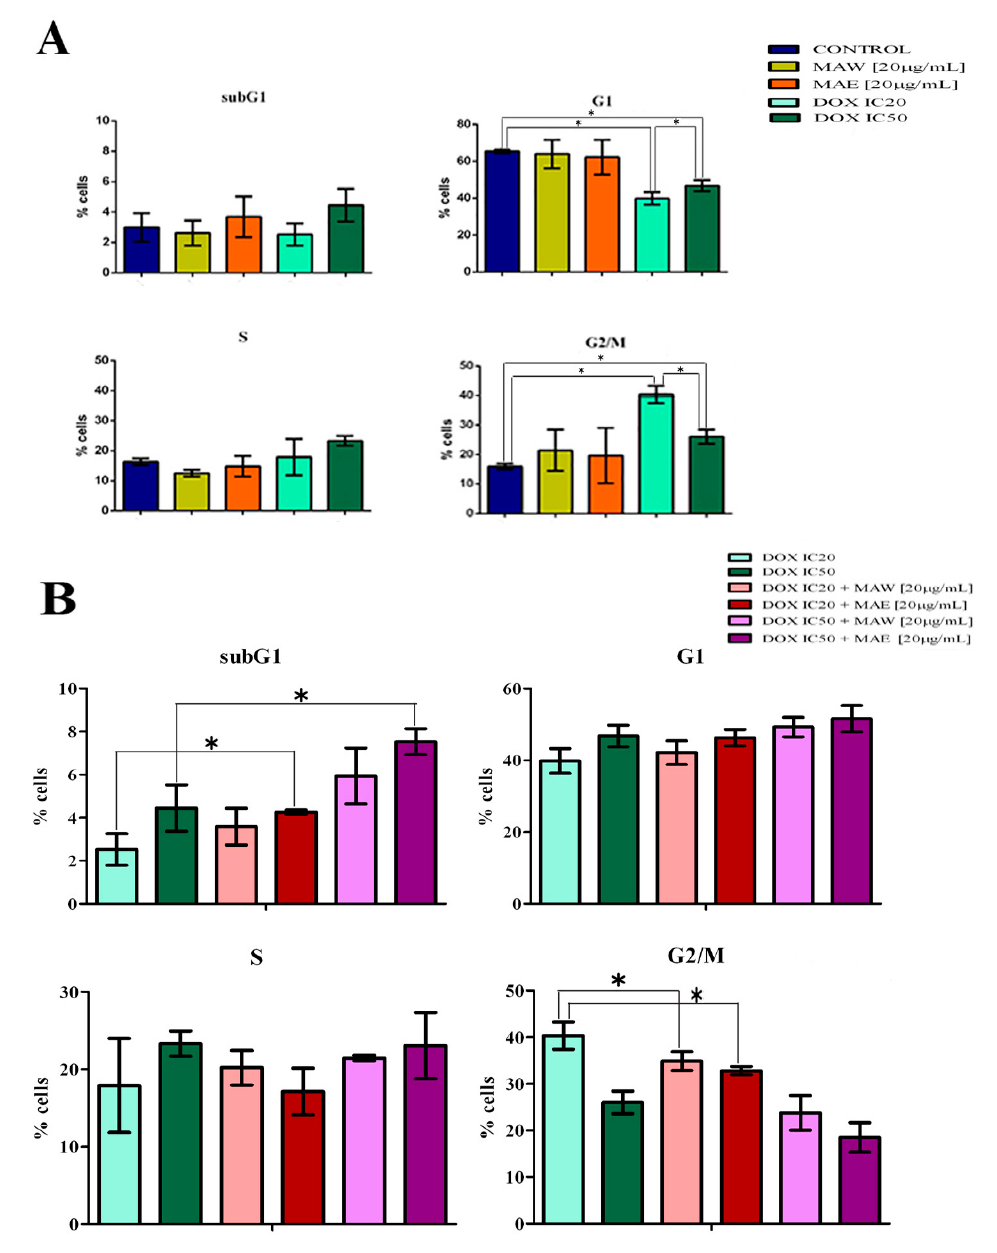
Figure 1. Changes in the cell cycle phase distribution of A549 cells after 24 h of treatment induced by ( A ) MAW (20 µ g / mL), MAE (20 µ g / mL), DOX IC20, or DOX IC50 compared to the control and ( B ) combination DOX / extract treatment compared to DOX treatment alone.